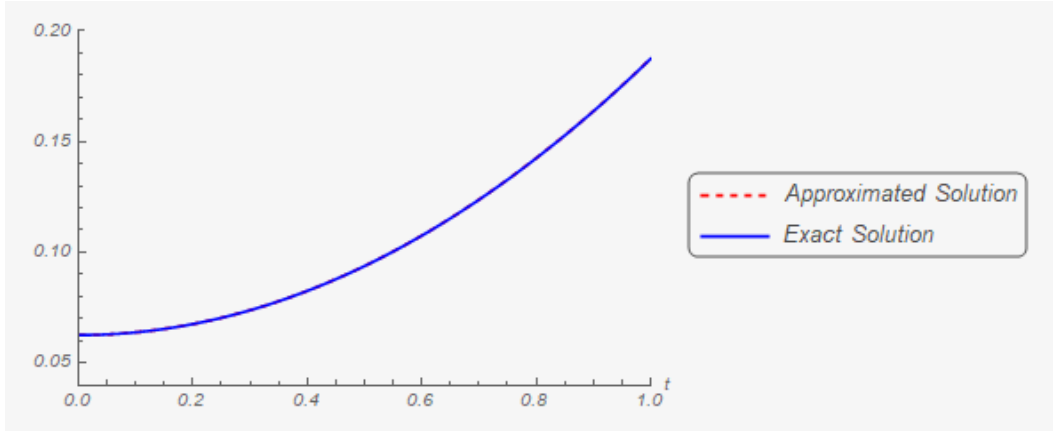
Figure 13. The first component of the exact solution and its three hundredth approximation.